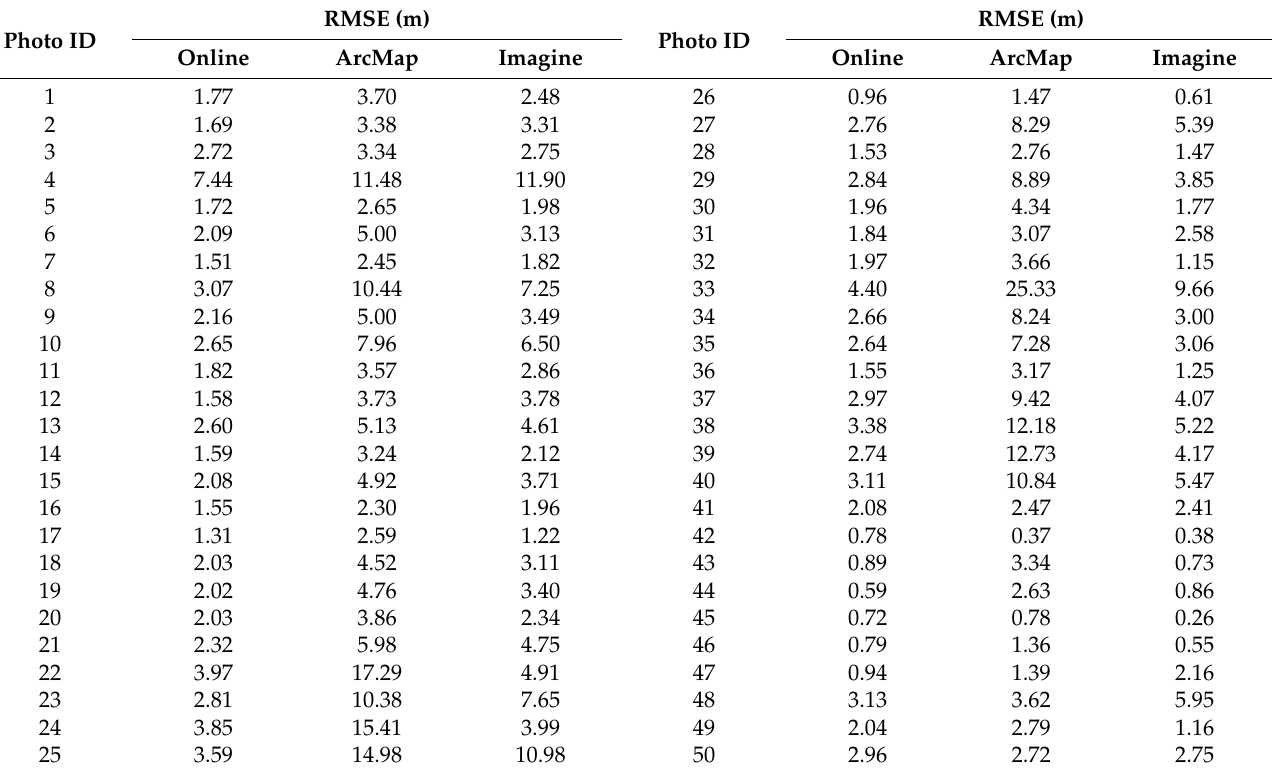
Table 1. RMSE of Each Historical Aerial Photo in Three Georeferencing